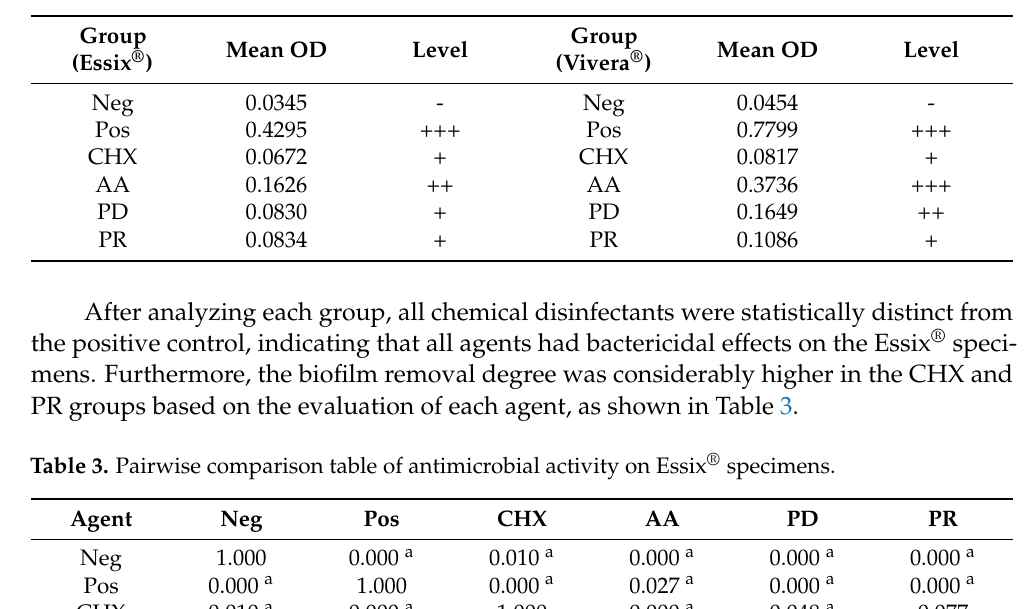
Table 2. The level of bacterial adherence on Essix ® retainer after cleaning.